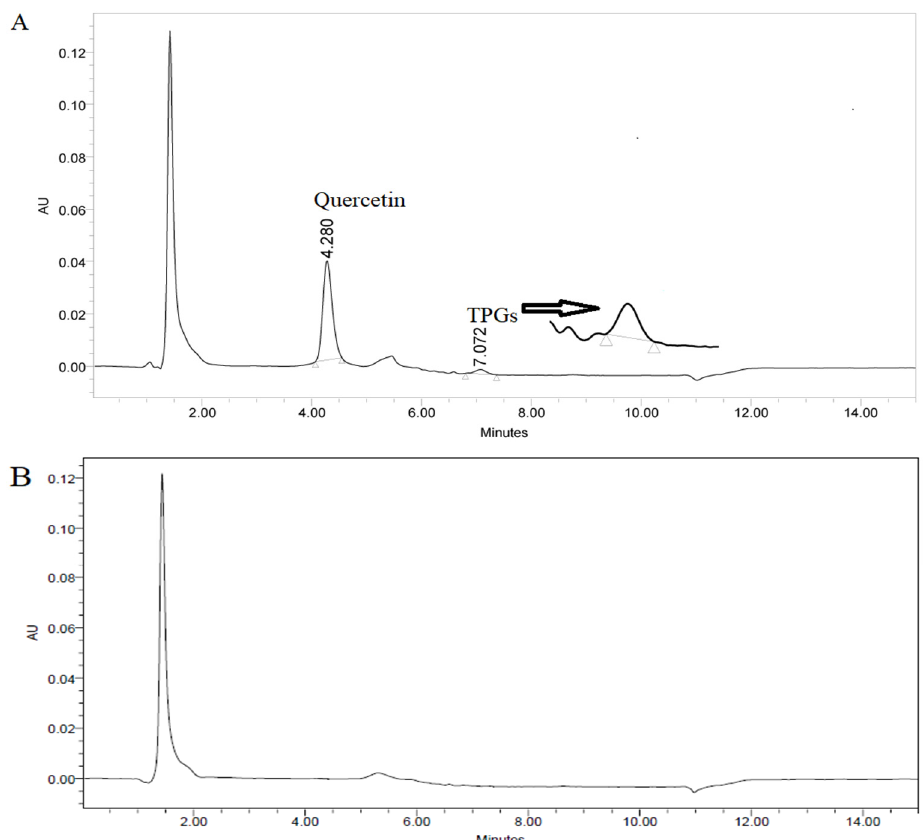
Figure 3. Representative chromatogram of 10 µg/mL quercetin and D- α -Tocopherol polyethylene glycol 1000 succinate (TPGS) in rat plasma under the optimized conditions, A against the blank plasma, B .